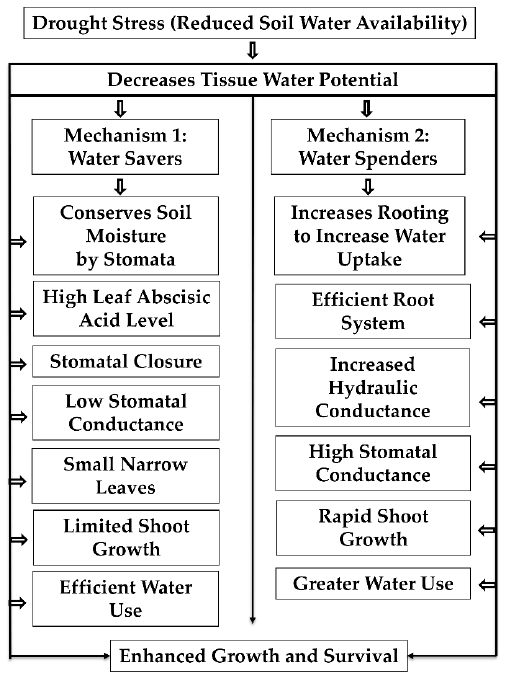
Figure 1. Drought tolerant mechanisms in crop plants. Reduced soil moisture causes drought stress plants to adapt either water saver or water spender mechanisms. The plants expressing water saver mechanisms conserve soil moisture for later stages of growth through reduced transpiration achieved by decreased leaf area, stomatal conductance, and increased abscisic acid levels. In contrast, the water spenders increase rooting depth to improve the water uptake, increase hydraulic conductance, and development of efficient root systems to extract more water from the soil to avoid drought